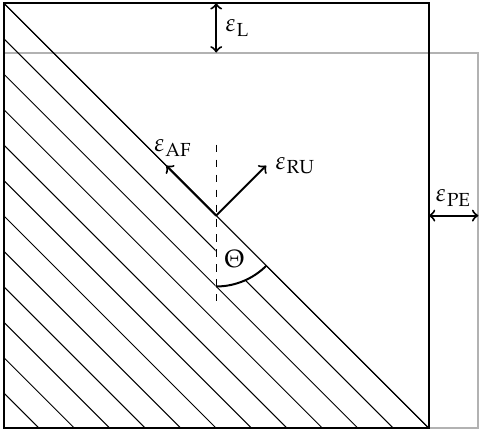
Figure 4. Schematic of the PMA membrane and the fiber